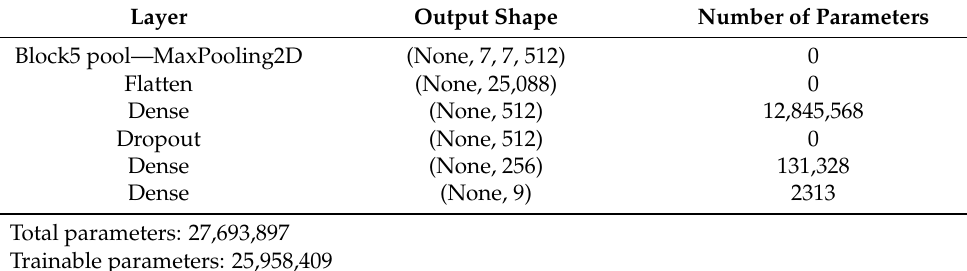
Table 4. Summary of the custom layers added to pre-trained VGG16